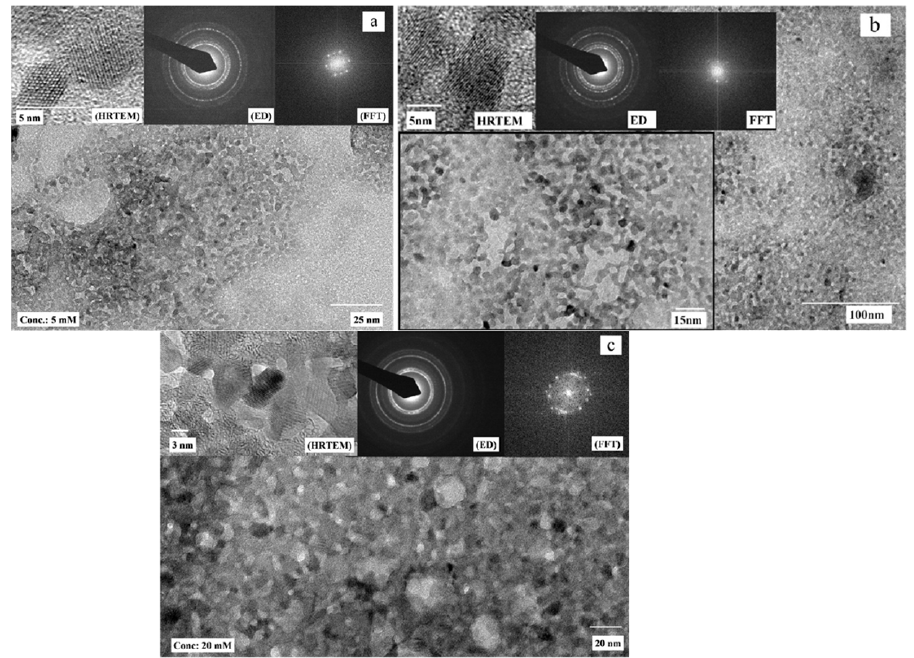
Figure 5. Electron microscope image of ZnO nanoparticles: the concentration of precursor is ( a ) 5 mM, ( b ) 10 mM, and ( c ) 20 mM. Reprinted/adapted with permission from Ref. [72]. Copyright © 2022, Elsevier Ltd.